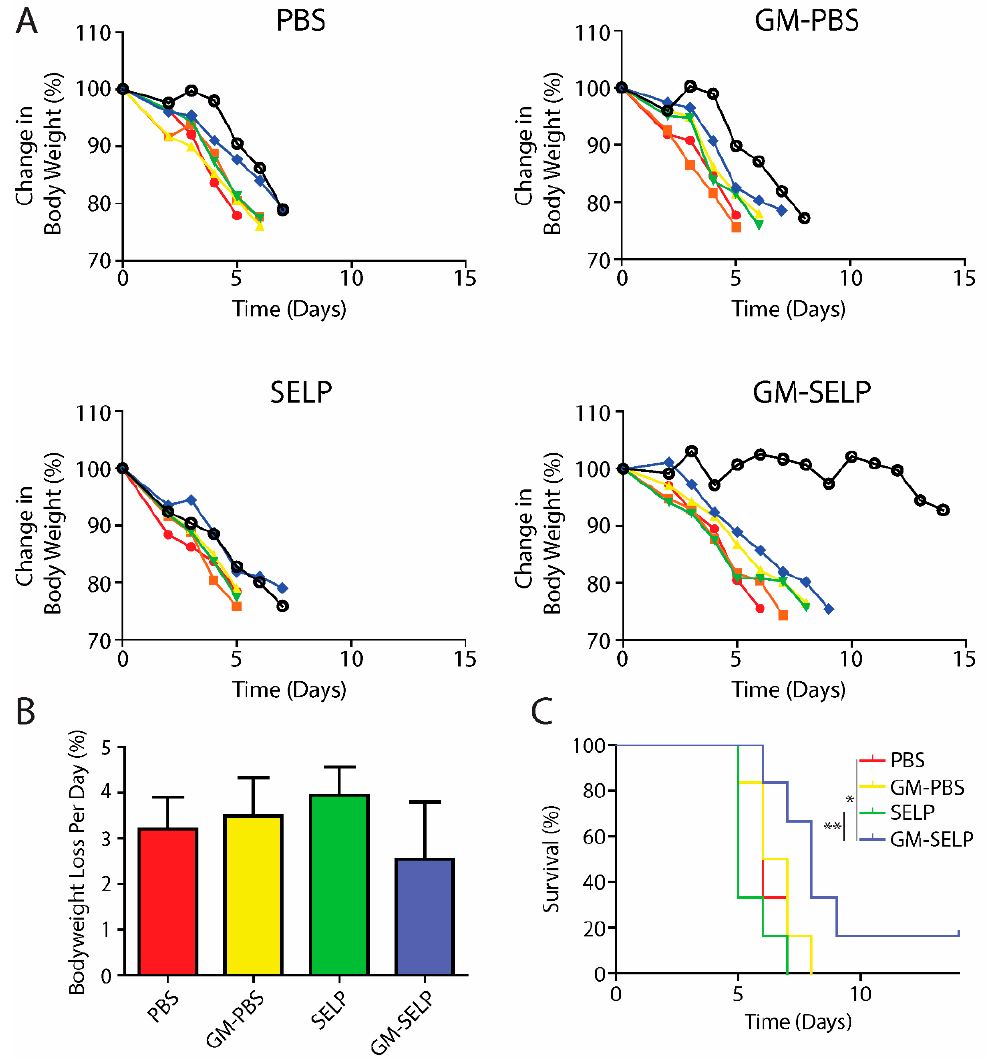
Figure 3. Animal body weights and survival. ( A ) Change in mice body weight as a percentage of baseline weights. Each line represents the body weight of a single animal. ( B ) Mean percentage of body weight loss per day. ( C ) Survival curves of irradiated animals receiving prophylactic treatments. (** p < 0.01, * p < 0.05).